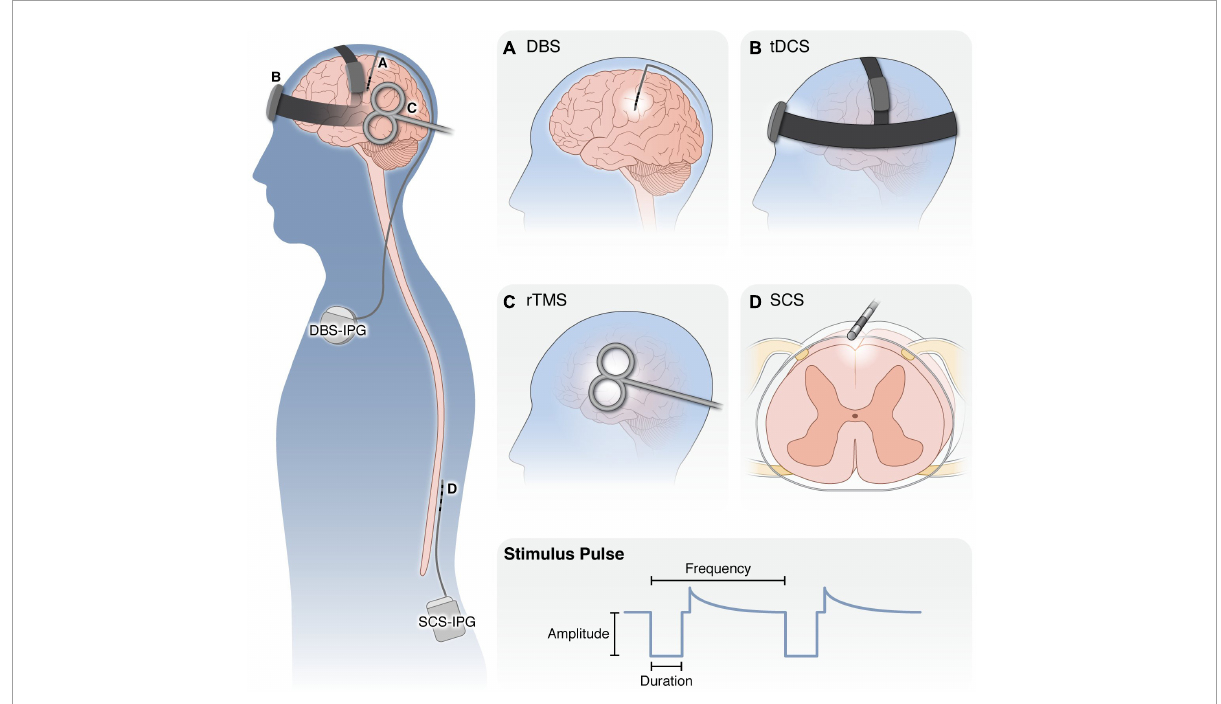
FIGURE2 Overview of neurostimulation modalities for the treatment of chronic pain. (Left) Schematic of application of neurostimulation devices for the treatment of chronic pain. (A) DBS electrodes are surgically targeted to specific brain nuclei (i.e., ACC, midline thalamus, PAG) with an external pulse generator. Following optimization of stimulation settings, the pulse generator and leads are internalized under the clavicle to deliver electrical stimulation to the brain. (B) With tDCS, small amounts of electric current are applied externally via electrodes held in place against